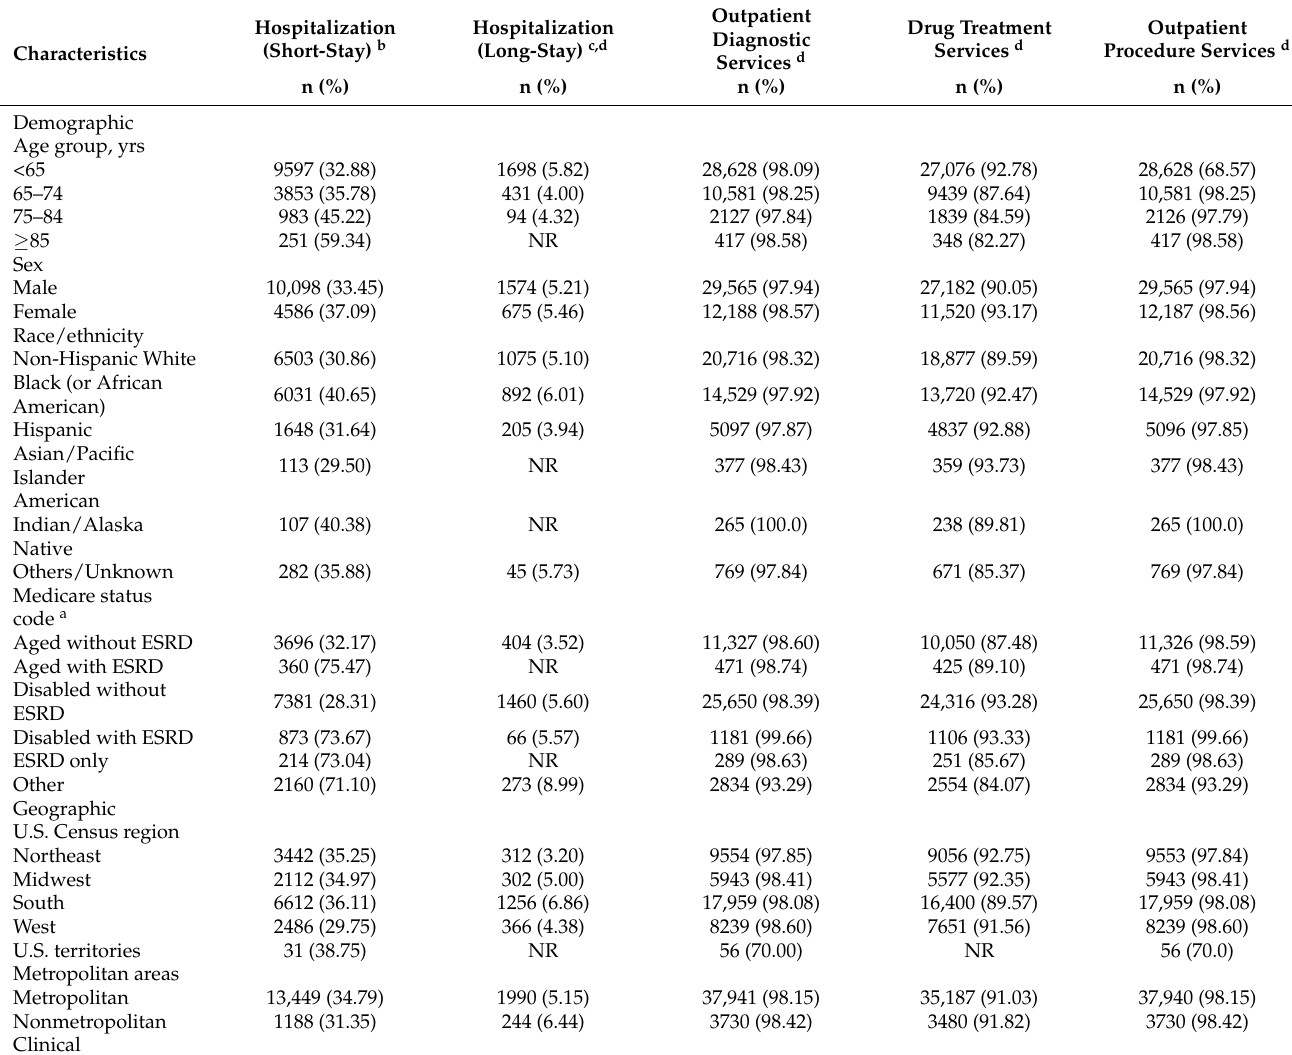
Table 2. Health care services utilization among Medicare beneficiaries with fee-for-service claims for HIV and depression, United States,